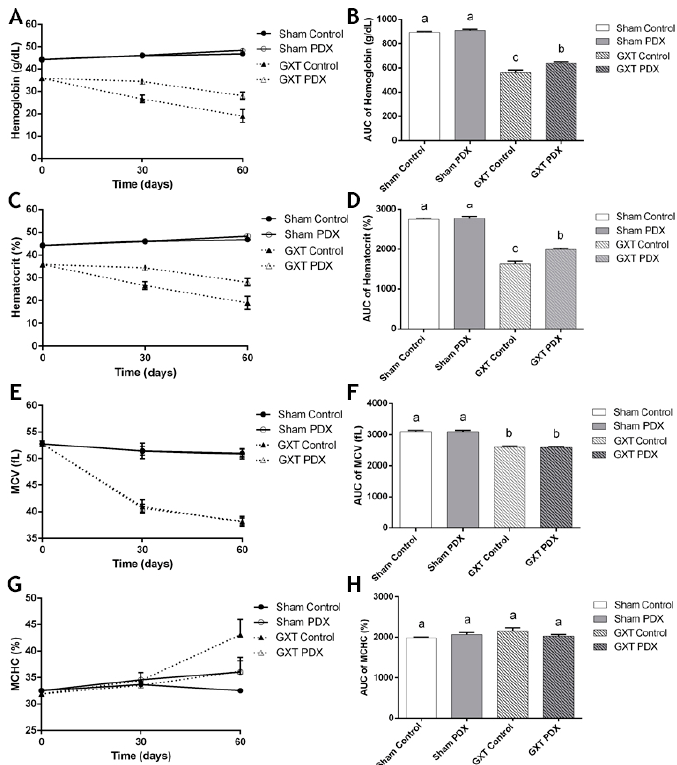
Figure 5. Hematologic parameters of experimental groups. Hemoglobin (g/dL) concentrations at different times ( A ) and area under the curve ( B ). Hematocrit (%) levels at different times ( C ) and area under the curve ( D ). MCV (fL) levels at different times ( E ) and area under the curve ( F ). MCHC (%) levels at different times ( G ) and area under the curve ( H ). Absence of letters and bars with same letters indicate no significant difference according to Tukey’s test ( p < 0.05). Different letters indicate a significant difference according to Tukey’s test ( p < 0.05). Sham Control: sham without polydextrose; Sham PDX: sham with polydextrose (7.5%); GXT Control: gastrectomized without polydextrose; GXT PDX: gastrectomized with polydextrose (7.5%). Values expressed as mean ± SEM.